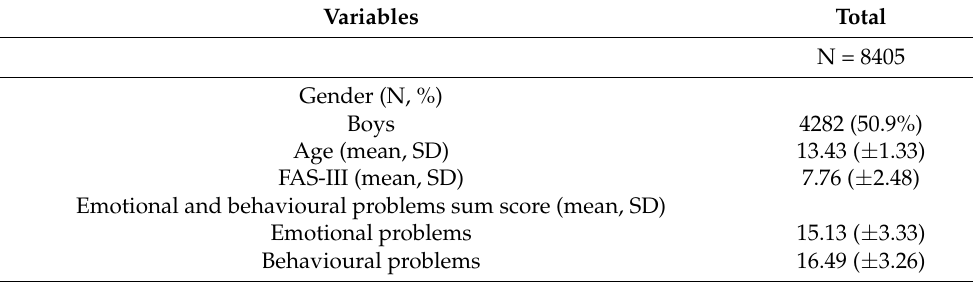
Table 1. Descriptive statistics of the sample (HBSC-study, Slovakia 2018, 11–15 years old, N = 8405).